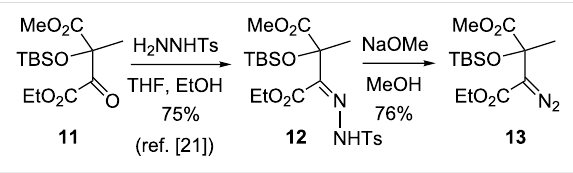
Scheme 3: Conversion of α -ketoester to α